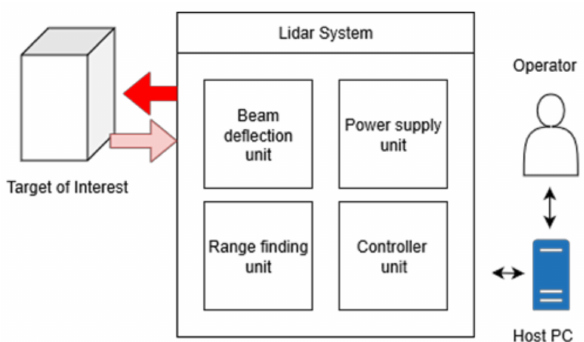
Figure 1. Block diagram of light detection and ranging (LiDAR)